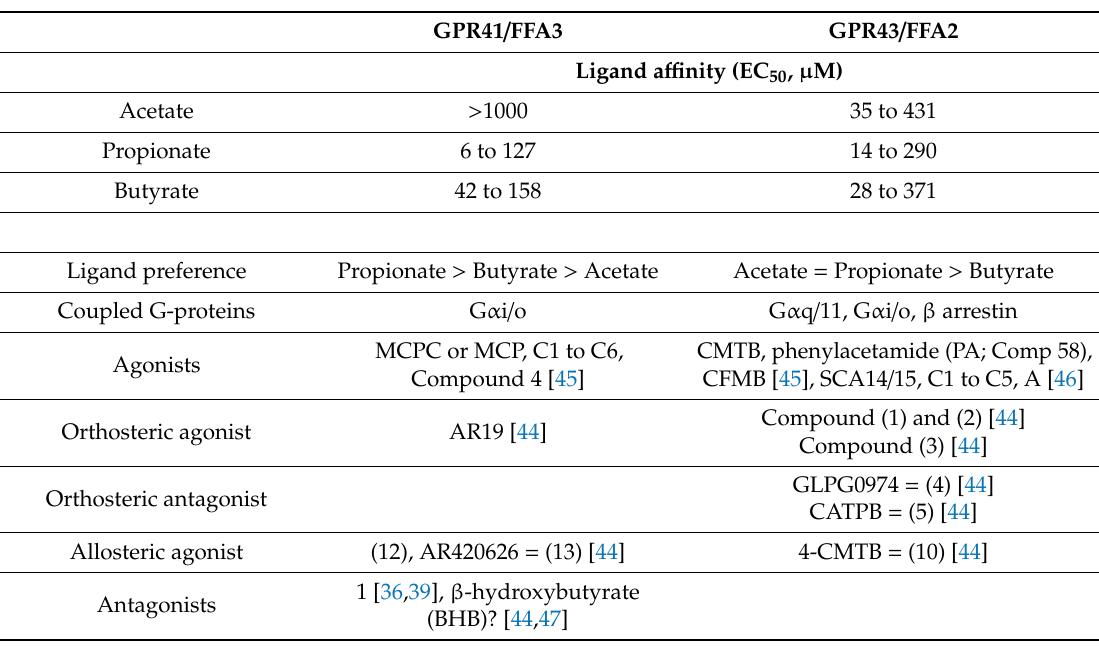
Table 1. Properties of short-chain fatty acids (SCFAs), their receptors, and associated ligands [40,42,43]. Compounds (1) and (2) were found to activate FFA2, then either G α i, G α q, or β -arrestin-2 [44]. Otherwise, there are only very limited reports in patent literature (https: // books.google.com /